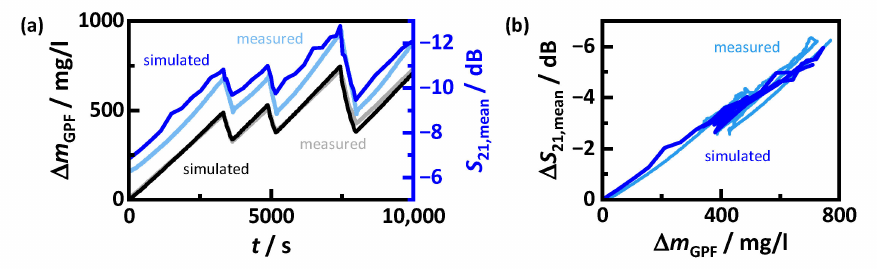
Figure 13. ( a ) Measured (see text to Figure 11) and simulated amount of soot stored in the GPF ∆ m GPF as well as RF signal attenuation S 21,mean (averaged in the frequency range from 1.68 to 1.78 GHz) during filter loading; ( b ) measured and simulated change in the mean RF signal attenuation ∆ S 21,mean depending on the stored soot ∆ m GPF